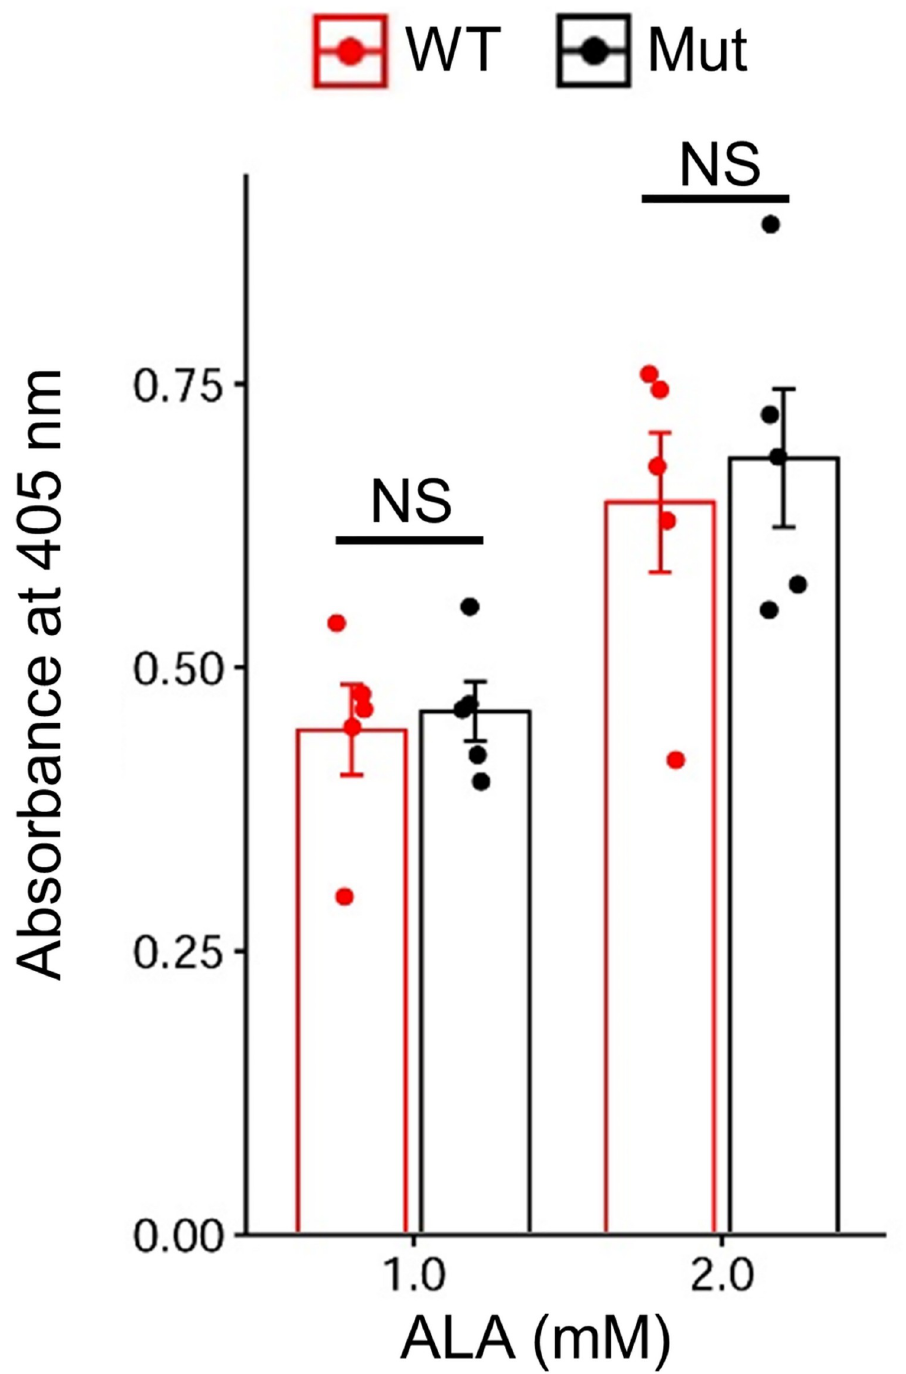
Fig 6. Comparison of the PPIX-forming abilities of the uterine homogenates between the wild-type and mutant quails. Absorbance of uterine homogenates incubated in the presence of different concentrations of 5’-aminolevulinic acid (ALA). Bars indicate the mean absorbance at 405 nm per 1 mg/mL total protein. Dots indicate the absorbance of each sample. Error bars indicate the standard error of the mean.